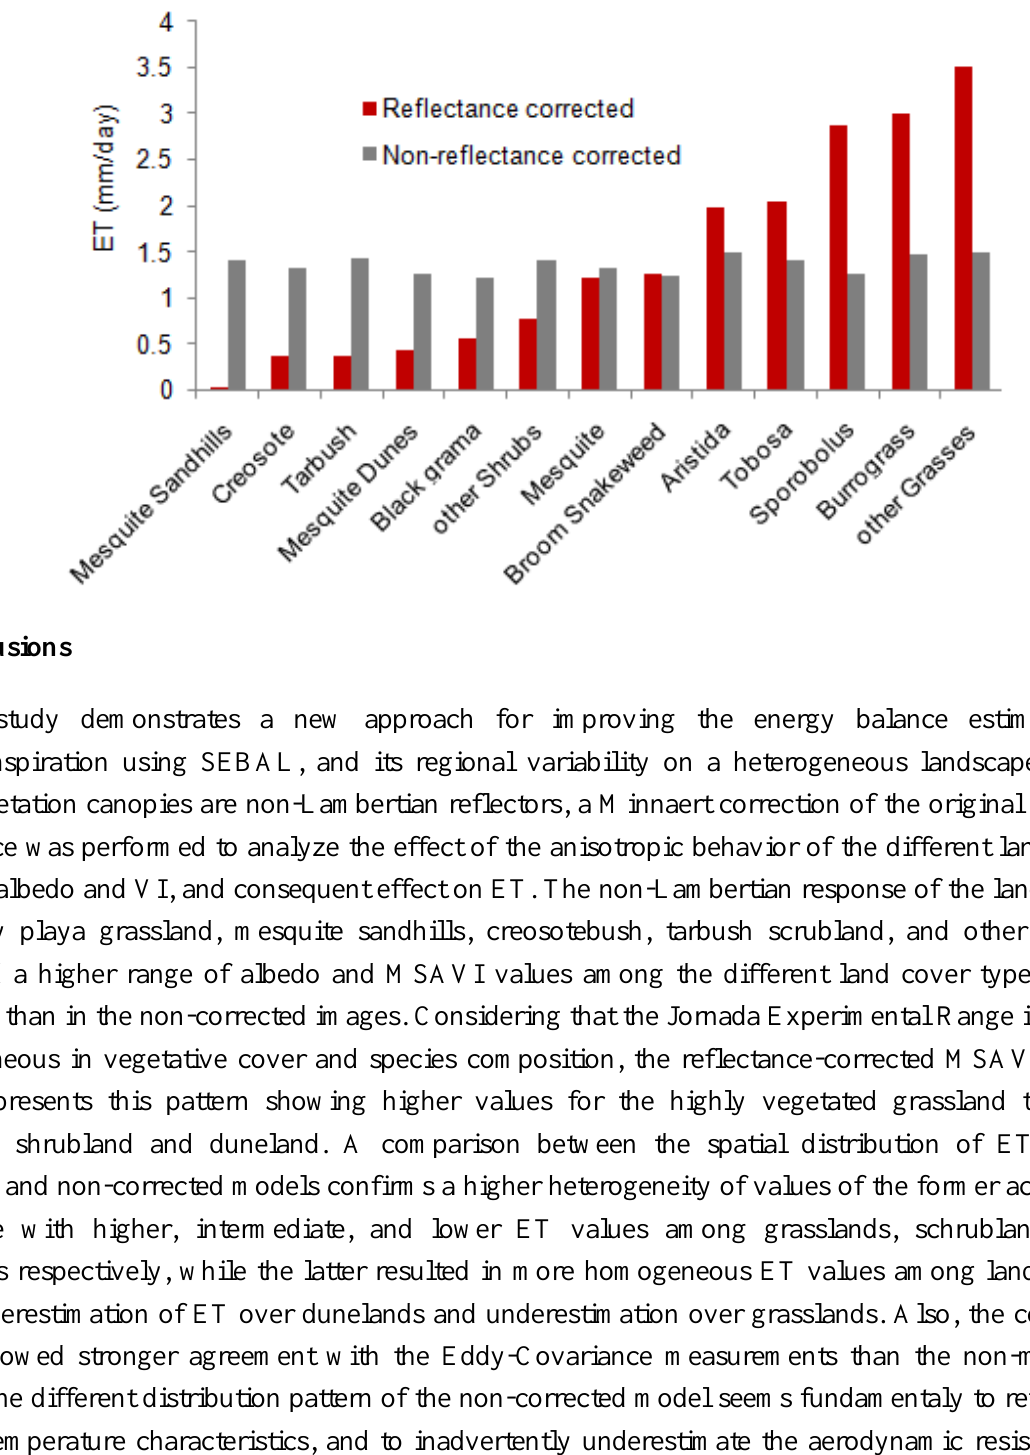
Figure 10. Mean ET (mm/day) of each land cover